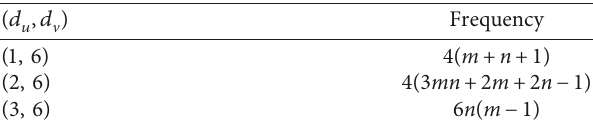
Table 2: Partition of E ( BiI